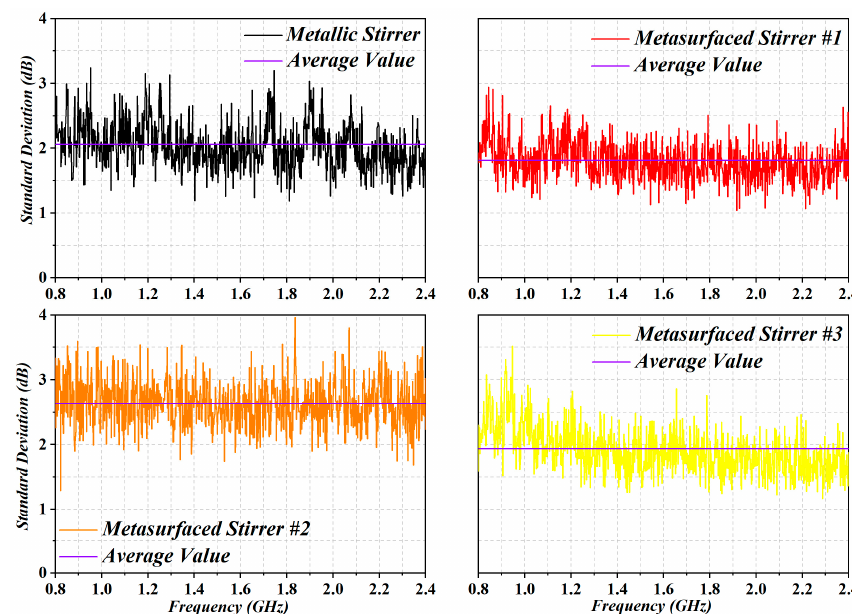
Figure 6. Standard deviation with respect to the mean value of maximum simulated obtained by each of the 12 steps, for a complete rotation of the stirrer.